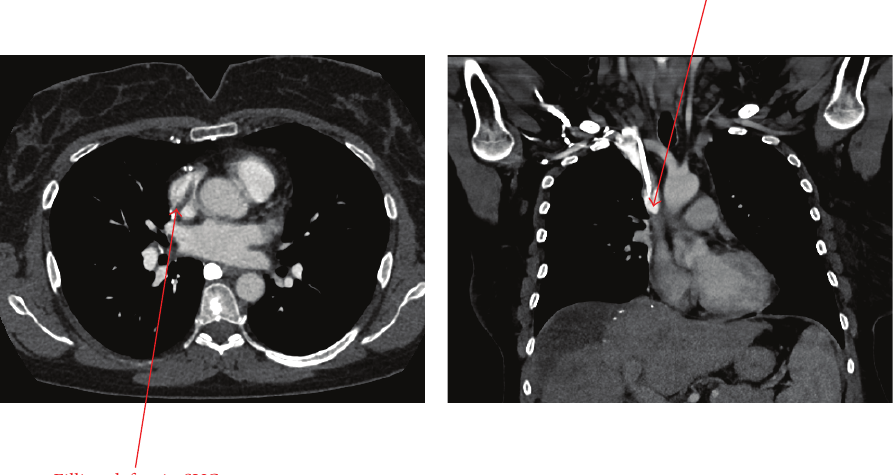
Figure 1: CT angiography of the chest showing a filling defect in the SVC and contrast cut-off at the SVC-RA junction caused by a